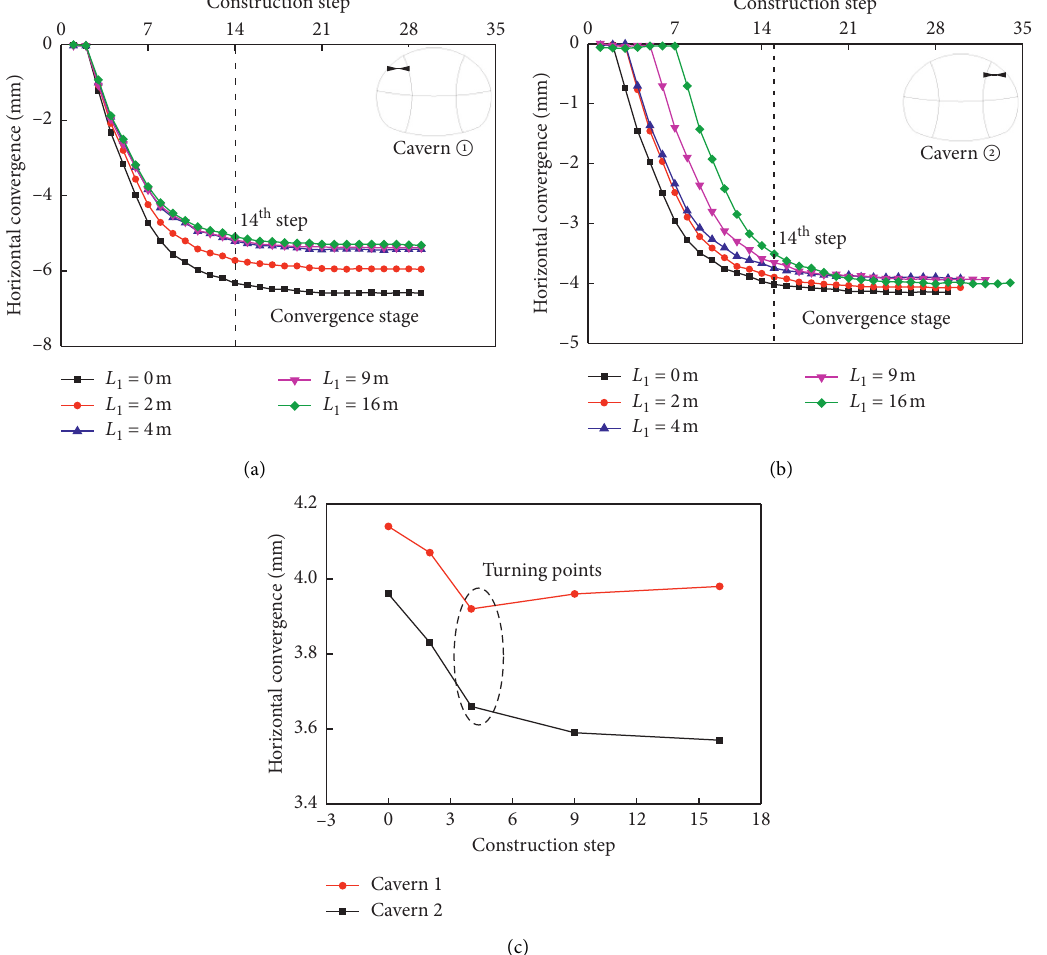
Figure 5: Horizontal deformation characteristics of caverns ① and ② . (a) Horizontal convergence curve of cavern ① . (b) Horizontal convergence curve of cavern ② . (c) Change trend of convergence value of horizontal deformation curves of caverns ① and ②